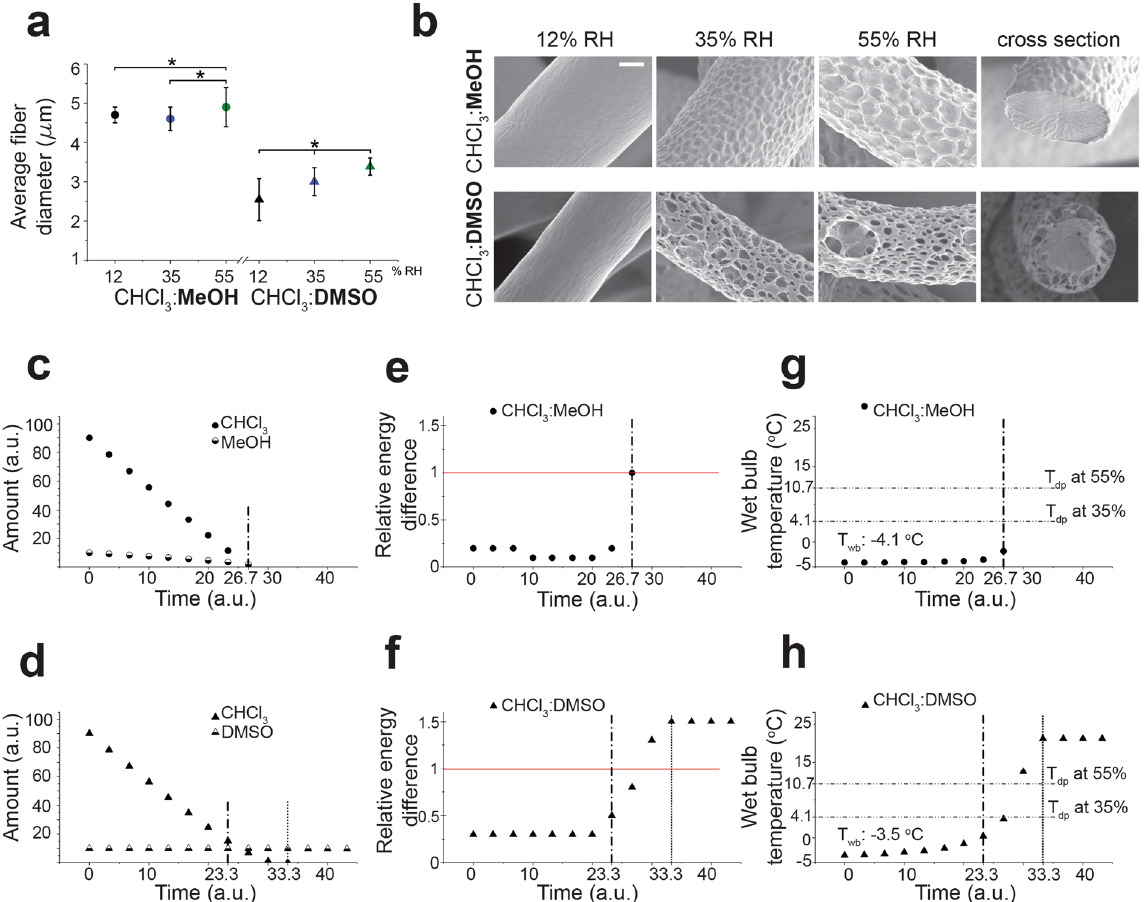
Figure 3. Resulting PCL fiber morphologies, simulated solvent evaporation and RED value changes during fiber formation for the solvent systems CHCl 3 :MeOH and CHCl 3 :DMSO: ( a ) Comparison of average fiber diameter of electrospun fibers from CHCl 3 :MeOH and CHCl 3 :DMSO solutions. Data represent means ± s.d. * P < 0.05; ANOVA One-way test, ( b ) SEM micrographs of electrospun fibers from CHCl 3 :MeOH (upper row) and CHCl 3 :DMSO (lower row) solutions at 12, 35, 55% RH, respectively (scale bar: 1 µ m), ( c , d ) simulated evaporation of CHCl 3 and MeOH and CHCl 3 and DMSO, respectively from PCL solutions (assuming the initial total amount of a solution is 100 parts and the solvent amount changes by evaporation during electrospinning), ( e , f ) simulated RED value change during solvent evaporation from CHCl 3 :MeOH and CHCl 3 :DMSO solutions, respectively ( g , h ) wet bulb temperature change (°C) during solvent evaporation from CHCl 3 :MeOH and CHCl 3 :DMSO solutions, respectively, (dash-dot line) last time point of similar amounts of solvent (S) and non- solvent; (round dot line) time point S = 0; (red line) solubility limit for the polymer in the solvent